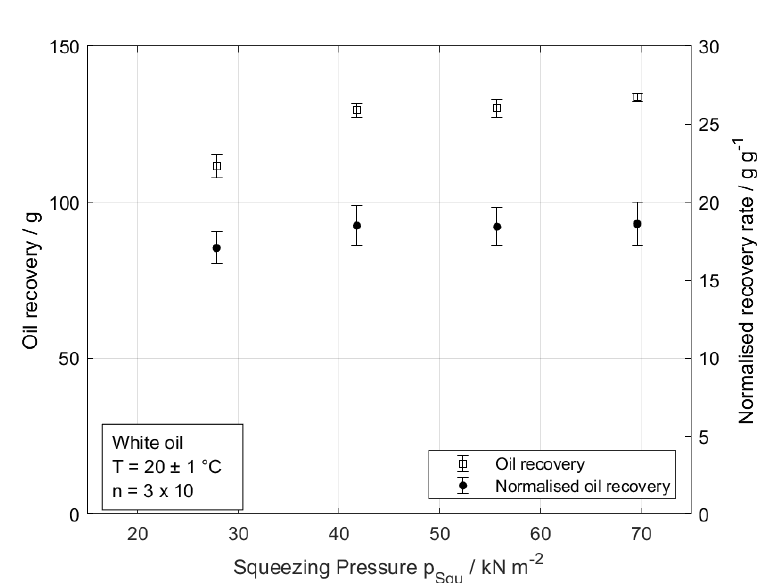
Figure 3. Total amount of recovered white oil (white squares, left ordinate) and normalised recovery rate (black circles, right ordinate) as a function of squeezing